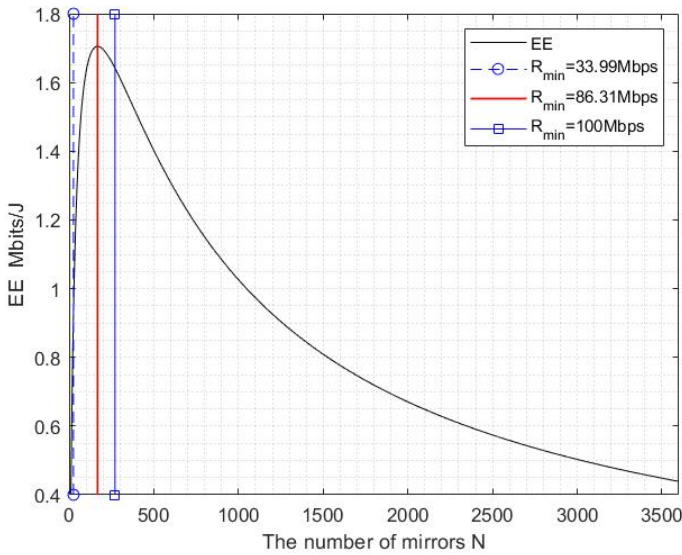
Table 2. Main simulation parameters.